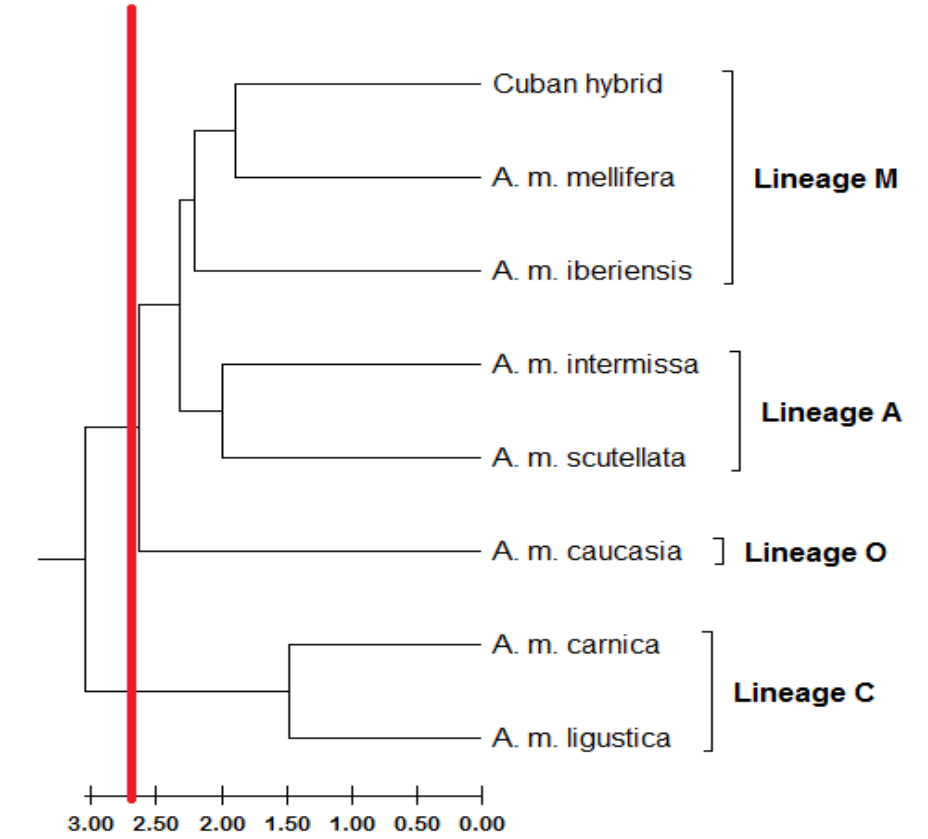
Figure 6. UPGMA phenogram showing the geometric morphometric relationship among honey bee subspecies based on Mahalanobis distances computed from the clusters of the pure subspecies of Apis mellifera and the centers for rearing queens. Method: Pairwise distance. Bee lineages: M, C, O, A. Subspecies: A. m. iberiensis , A. m. intermisa , A. m. mellifera , A. m. carnica , A. m. ligustica , A. m. caucasia , A. m. scutellata . Red line = phenon.